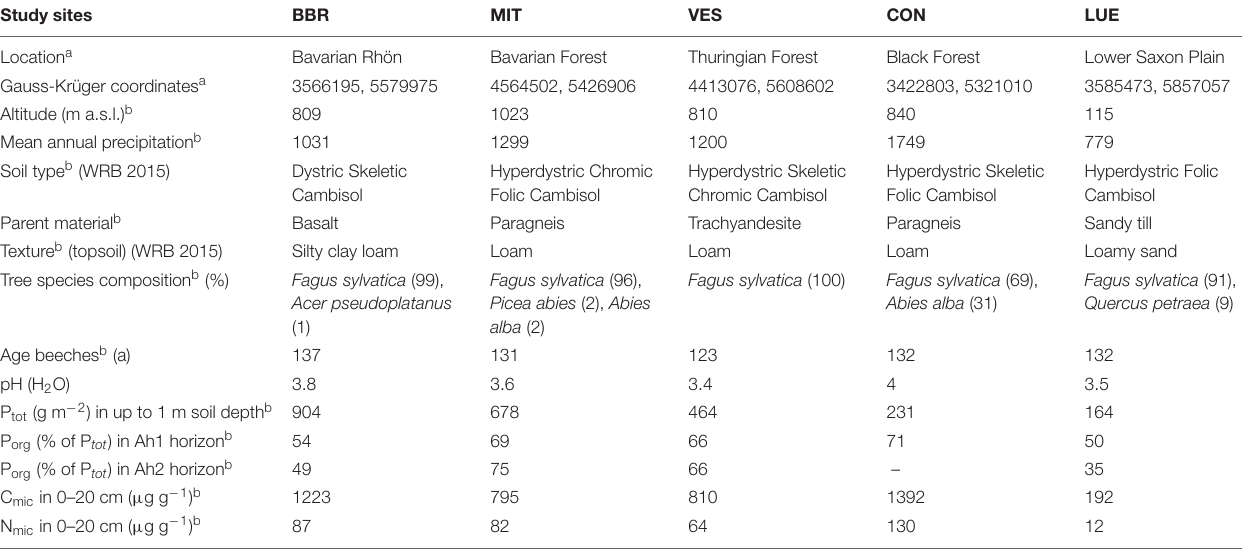
TABLE 1 | Summary of soil characteristics at the five study sites in Bad Brückenau (BBR), Mitterfels (MIT), Vessertal (VES), Conventwald (CON), and Lüss (LUE), modified from Lang et al. (2017). Study